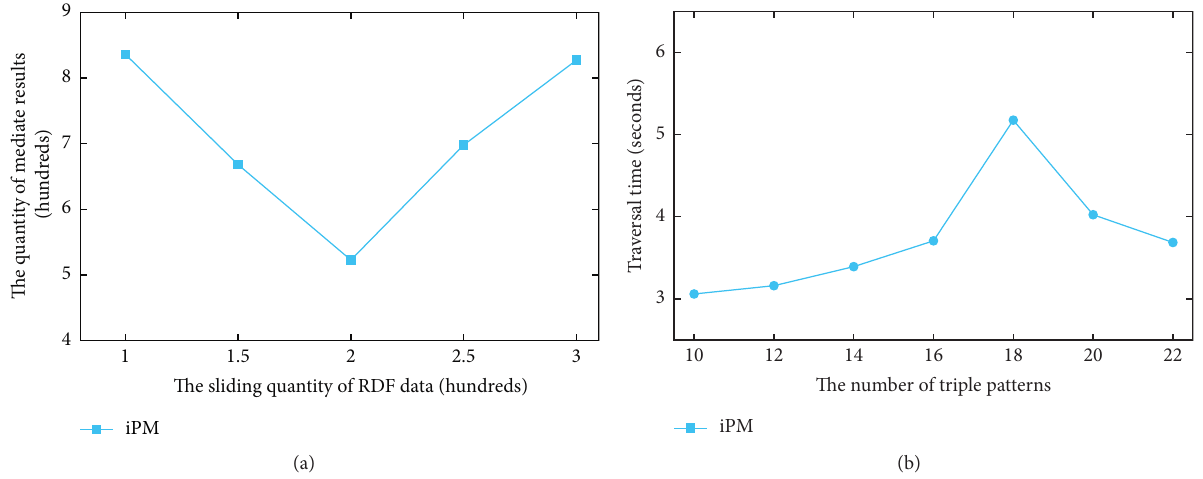
Figure 10: Performance evaluation on NY taxi dataset. (a) The quantity of mediate results with different sliding sizes. (b) traversal time with different query